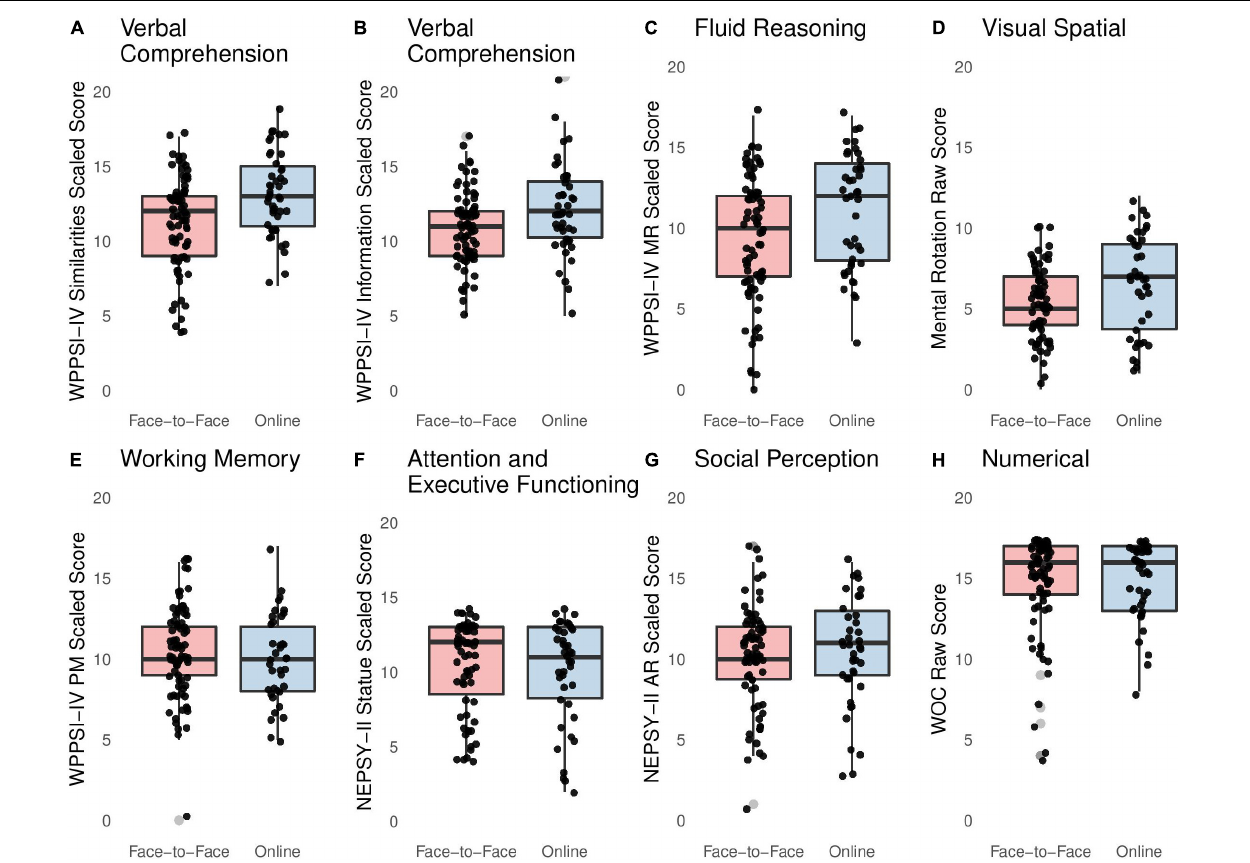
FIGURE 1 | Box plots representing distribution of scores in both formats: (A) WPPSI-IV Similarities Scaled Score, (B) WPPSI-IV Information Scaled Score, (C) WPPSI-IV MR Scaled Score, (D) Mental Rotation Raw Score, (E) WPPSI-IV PM Scaled Score, (F) NEPSY-II Statue Scaled Score, (G) NEPSY-II AR Scaled Score, and (H) WOC Raw Score.